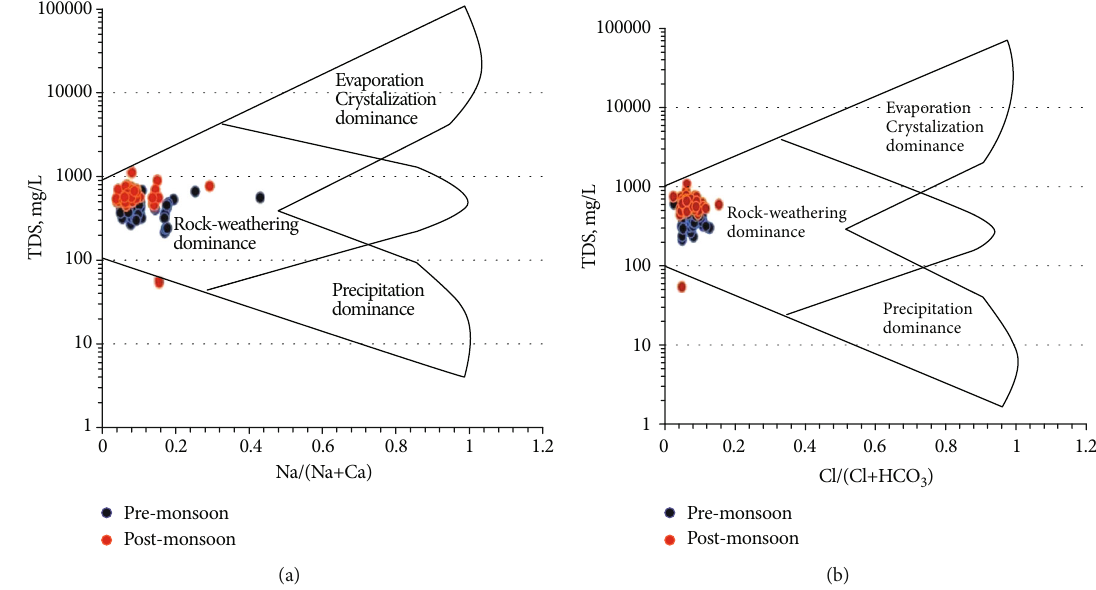
Figure 5: (a, b) Gibbs ’ s diagrams for groundwater samples of the study